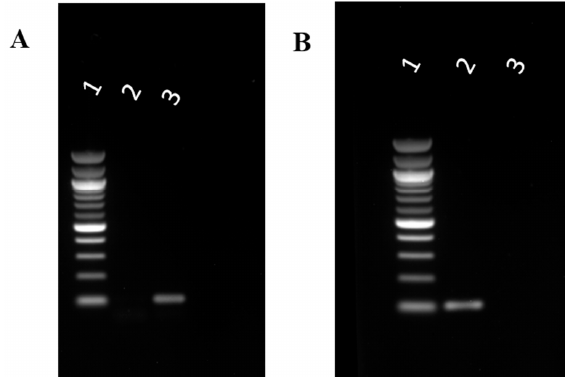
Figure 6. ( A ) Cell wall damage and leakage assay, where (1) 100 bp ladder, (2) PCR product of 16S rRNA of supernatant of VRSA cells without any treatment, and (3) PCR product of 16S rRNA of supernatant of VRSA cells treated with HSER–CQDs. ( B ) Interaction of the HSER-CQD with gDNA was studied using gel electrophoresis; (1) the 100 bp ladder, (2) PCR product of 16S rRNA of VRSA genomic DNA (control), and (3) PCR product of 16S rRNA of VRSA genomic DNA treated with HSER–CQDs. VRSA = Vancomycin Resistant Staphylococcus aureus . Based on net charge, cell-penetrating peptides can be either hydrophobic, amphipathic, or cationic [43]. The secondary structure of many cell-penetrating peptides and antimicrobial peptides has been studied in connection to their interaction with membranes. Some peptides, like penetratin, adopt either α -helix or β -sheet structure when interacting with the membrane, while polycationic peptides (like Tat and short poly-arginines) remain in unstructured random coils [44]. These peptides have high affinity to membranes with high concentrations of anionic lipids, and require formation of salt-bridges to obtain favorable energetic values for insertion in the membrane [45]. The pH (Low) Insertion Peptides (pHLIP peptides (low pH-dependent)) were shown to transform between three